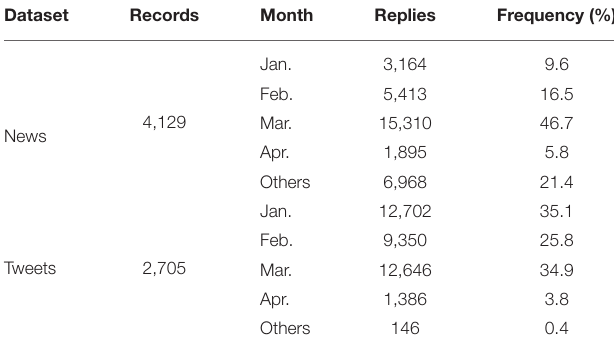
TABLE 1 | Summary of data